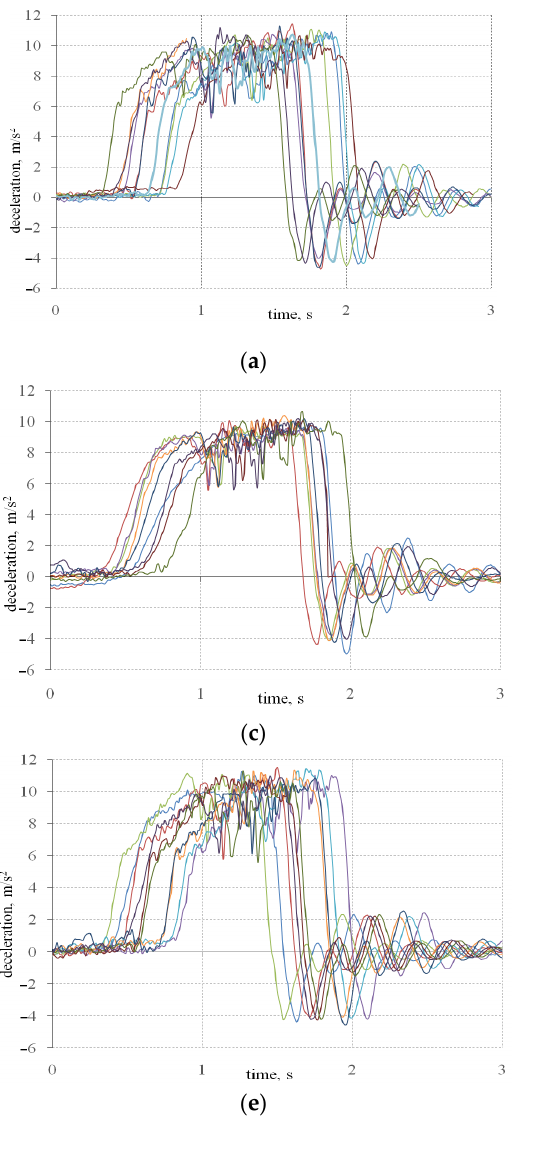
Figure 2. The presentation of values of longitudinal deceleration registered for a category N1 vehicle during the tests of rapid braking carried out on: ( a ) dry asphalt pavement from 30 km/h, ( b ) dry asphalt pavement from 50 km/h, ( c ) wet asphalt pavement from 30 km/h, ( d ) wet asphalt pavement from 50 km/h, ( e ) dry concrete pavement from 30 km/h, ( f ) wet concrete pavement from 30 km/h.